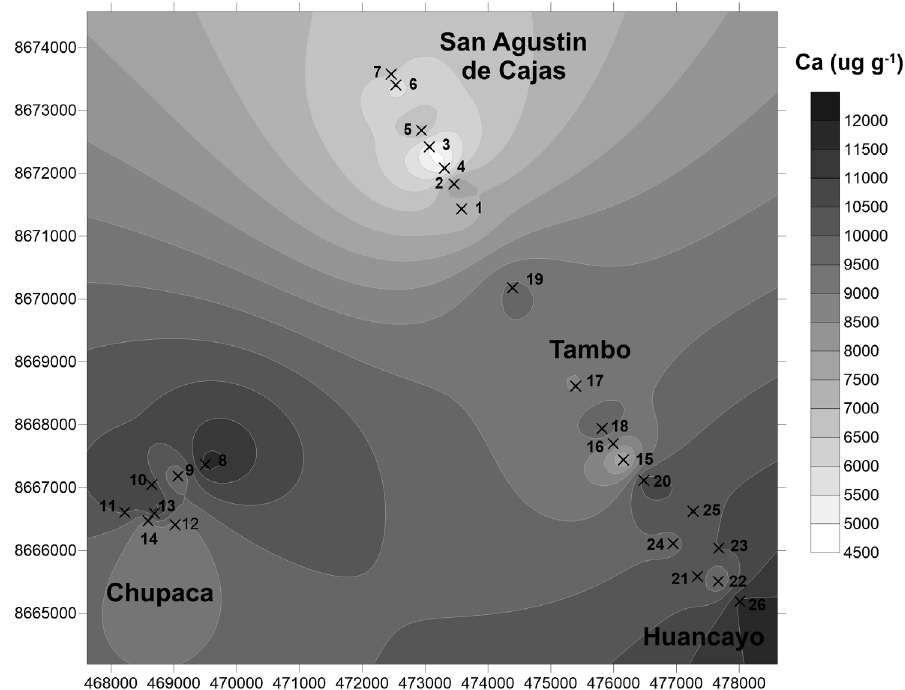
Figure 3. Distribution map of Ca